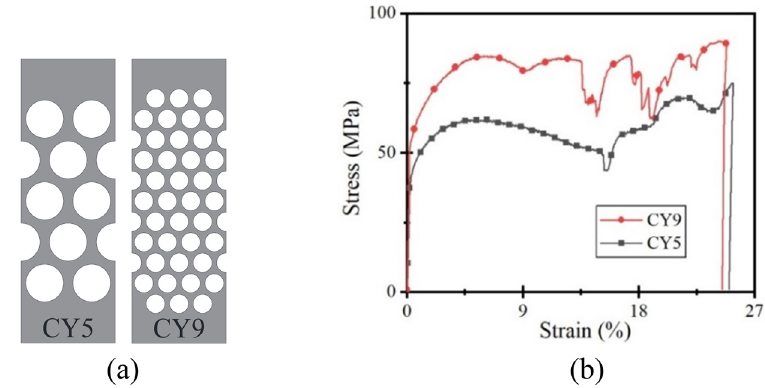
Figure 9: The e ff ect of void ratio: ( a ) hole arrangement and ( b ) stress – strain